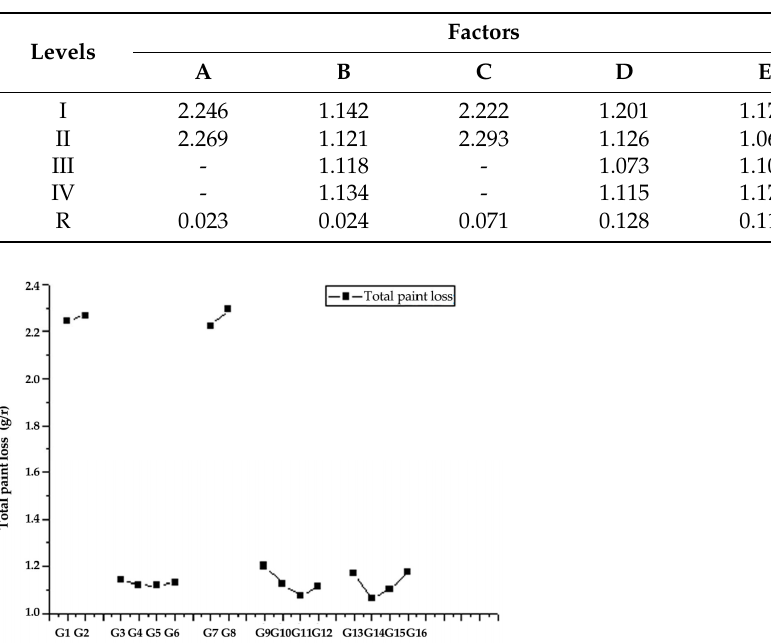
Table 10. Range analysis of the orthogonal experiment of total paint film mass loss.